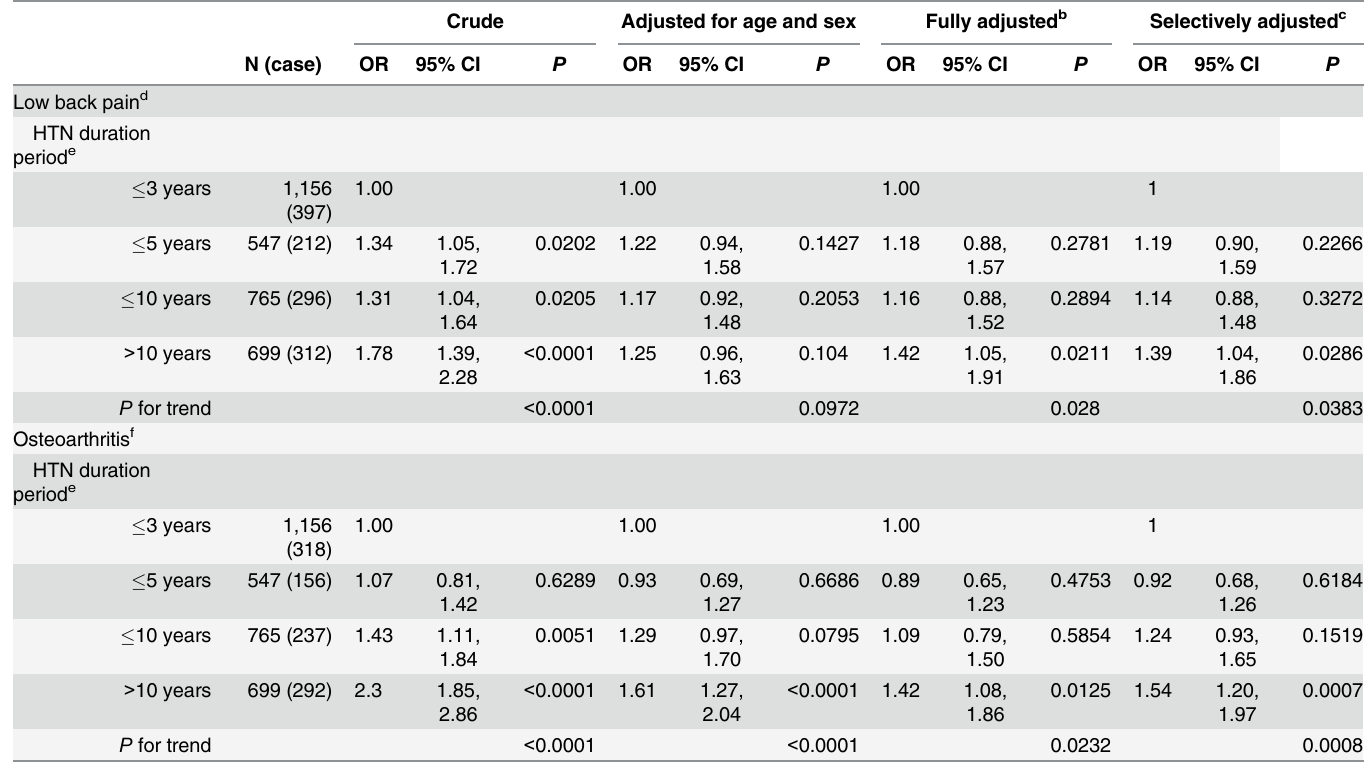
CI, con fi dence interval; KNHANES, Korean National Health and Nutrition Examination Survey; OR, odds ratio.